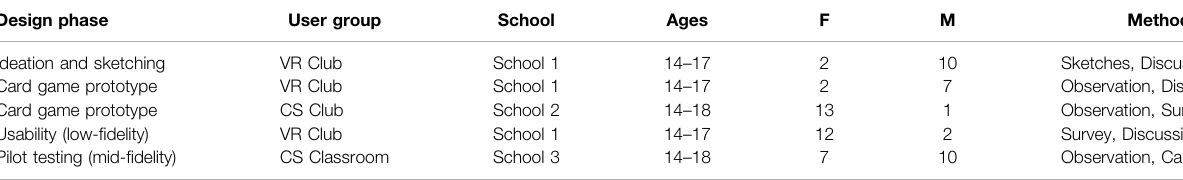
TABLE 1 | Demographics of teen participants for both the design phases and pilot testing. Design phase